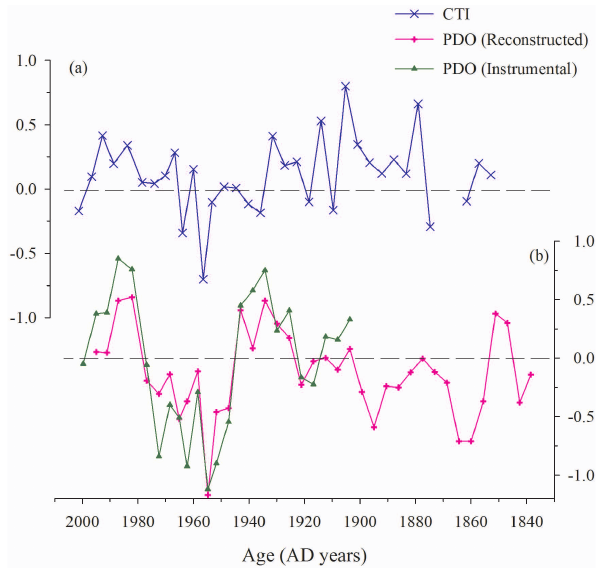
Fig. 5. The Cold Tongue Index (CTI); sea surface anomaly mi- nus global mean in the area 6 ◦ N–6 ◦ S, 180 ◦ –90 ◦ W (http://jisao. washington.edu/enso/) (a) and time-series of the Pacific Decadal Oscillation (PDO) reconstructed from tree rings from North Amer- ica (D’Arrigo et al., 2001) and instrumental data available from AD 1900 (Mantua et al., 1997) (b) . The original information was av- eraged to match the sampling intervals established by means of the age model estimated for core